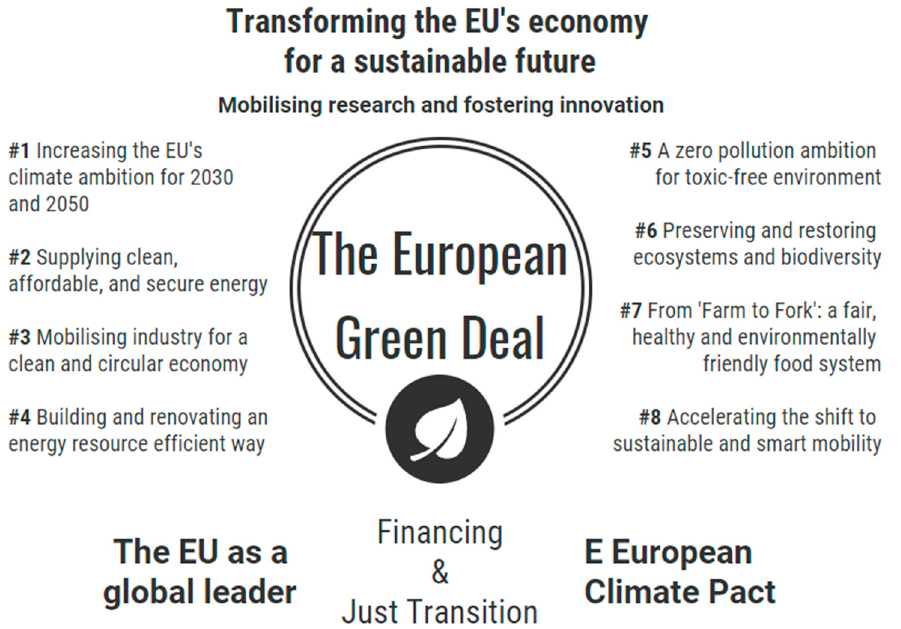
Figure 2. The European Green Deal(created using data from [37]).